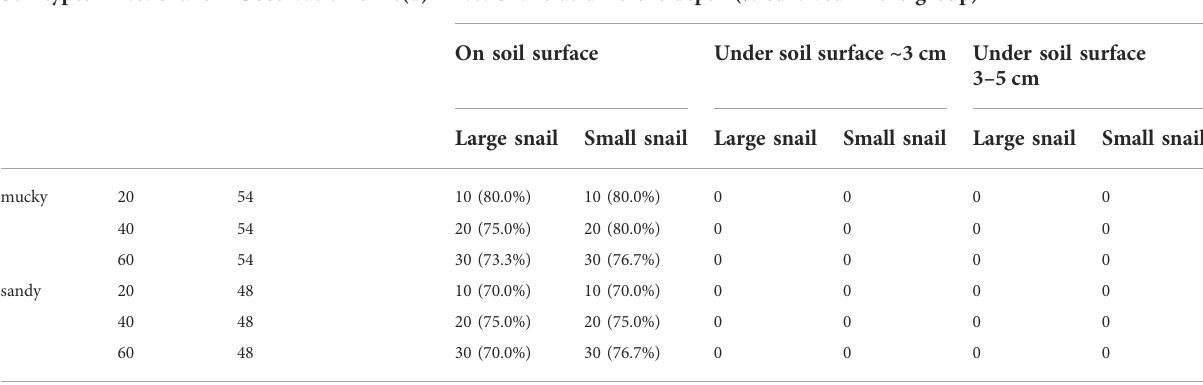
TABLE 1 The B. globosus snail parameters in Experiment 1 Soil